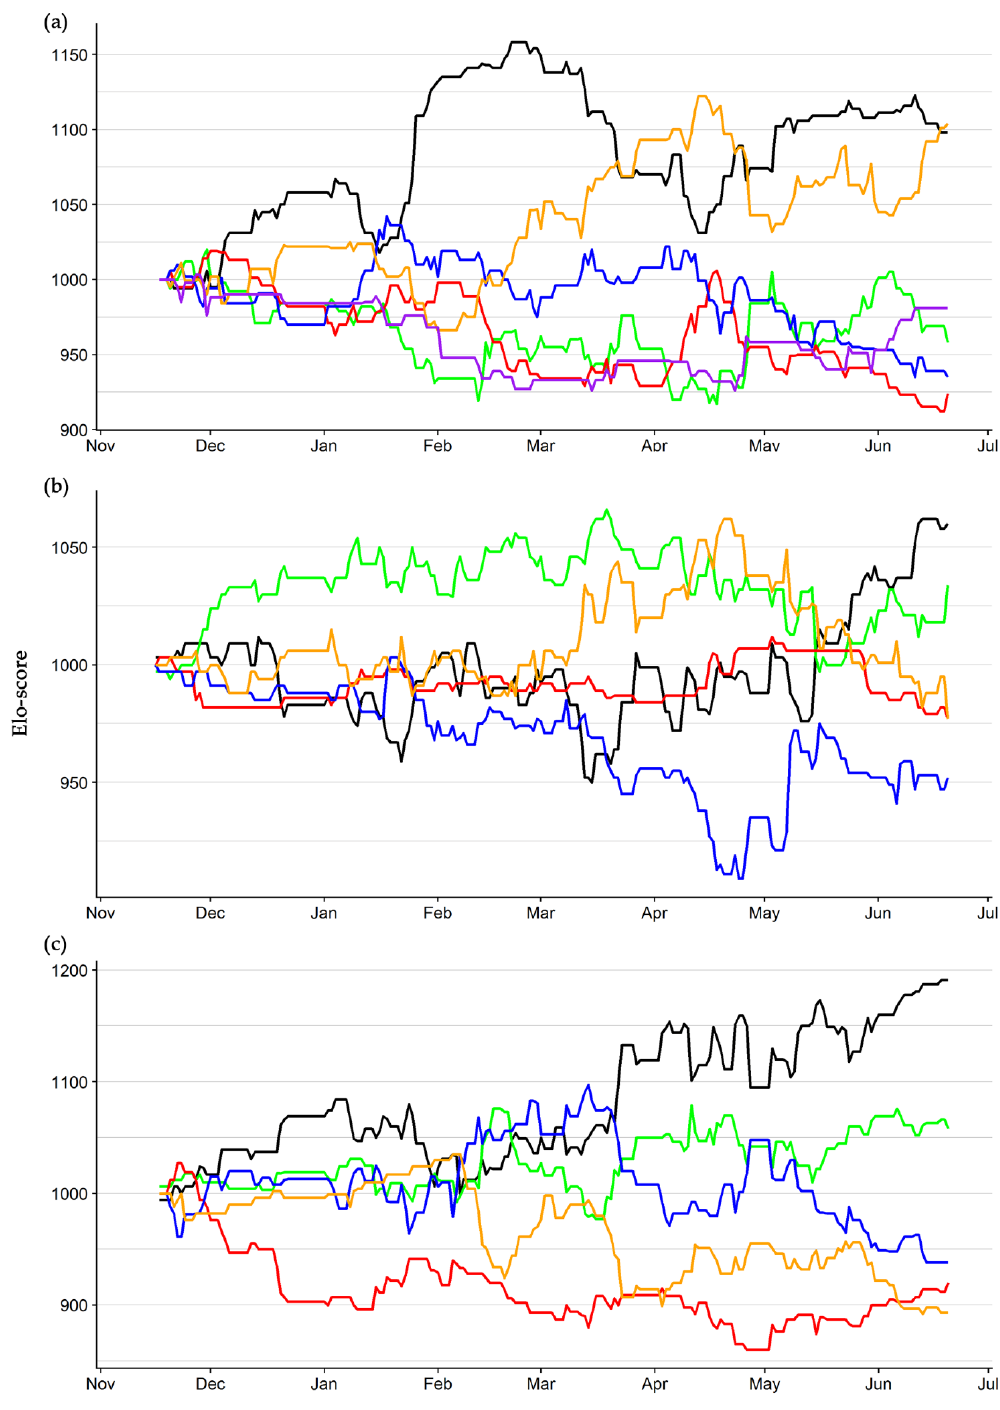
Figure 2. Elo-score dynamic of the hatchling European pond turtles reared in three separate units from November 2017 to June 2018. Group one ( a ): ID 7 (green), 12 (purple), 13 (black), 14 (orange), 15 (blue), 16 (red). Group two ( b ): ID 1 (orange), 2 (black), 4 (green), 9 (blue), 10 (red). Group three ( c ): ID 3 (green), 5 (black), 6 (red), 8 (orange), 11 (blue).